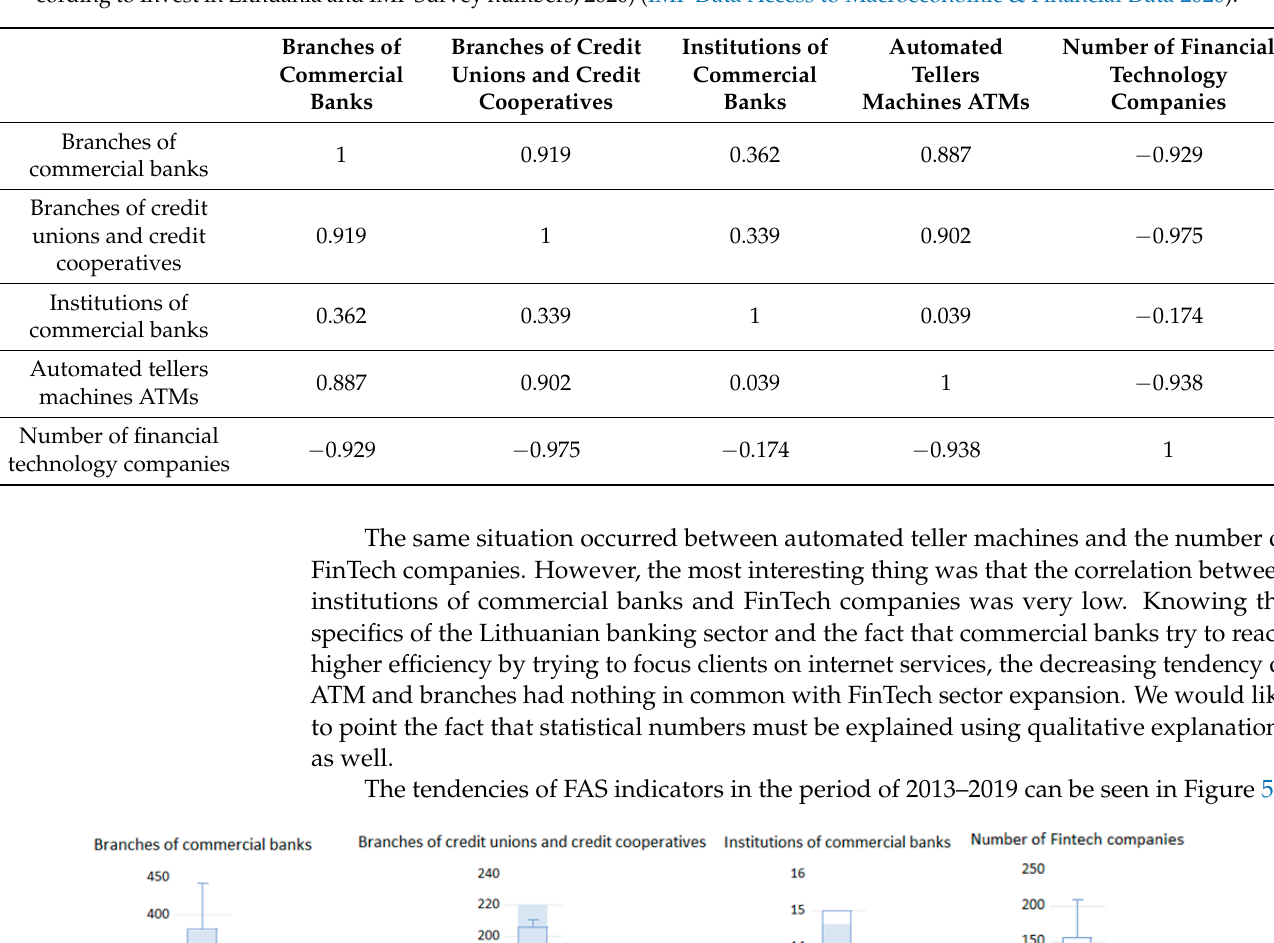
Table 2. Financial technology sector correlation with Financial Access Survey (FAS) indicators. (Composed by the authors ac- cording to Invest in Lithuania and IMF Survey numbers, 2020) (IMF Data Access to Macroeconomic & Financial Data 2020).